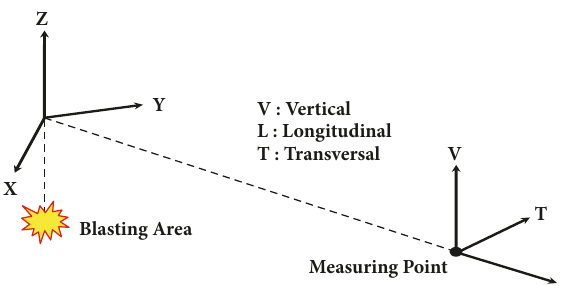
Figure 1: Schematic diagram on directions of blasting-induced vibration.